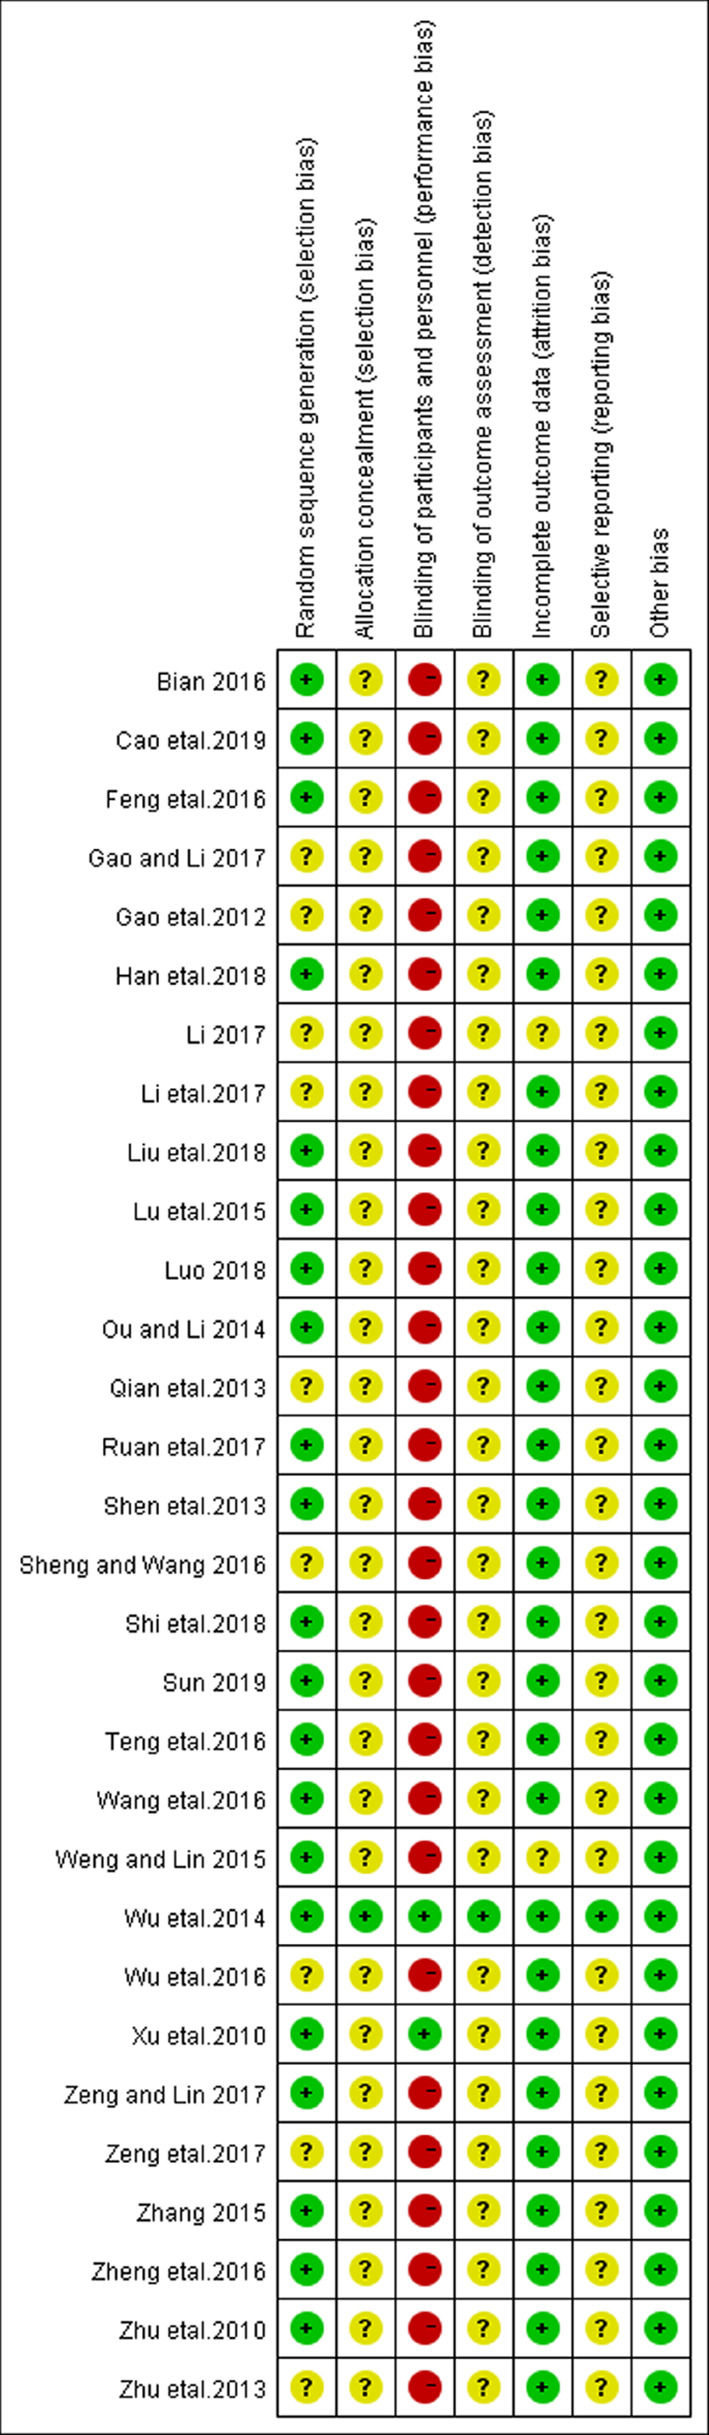
Risk of bias graph.